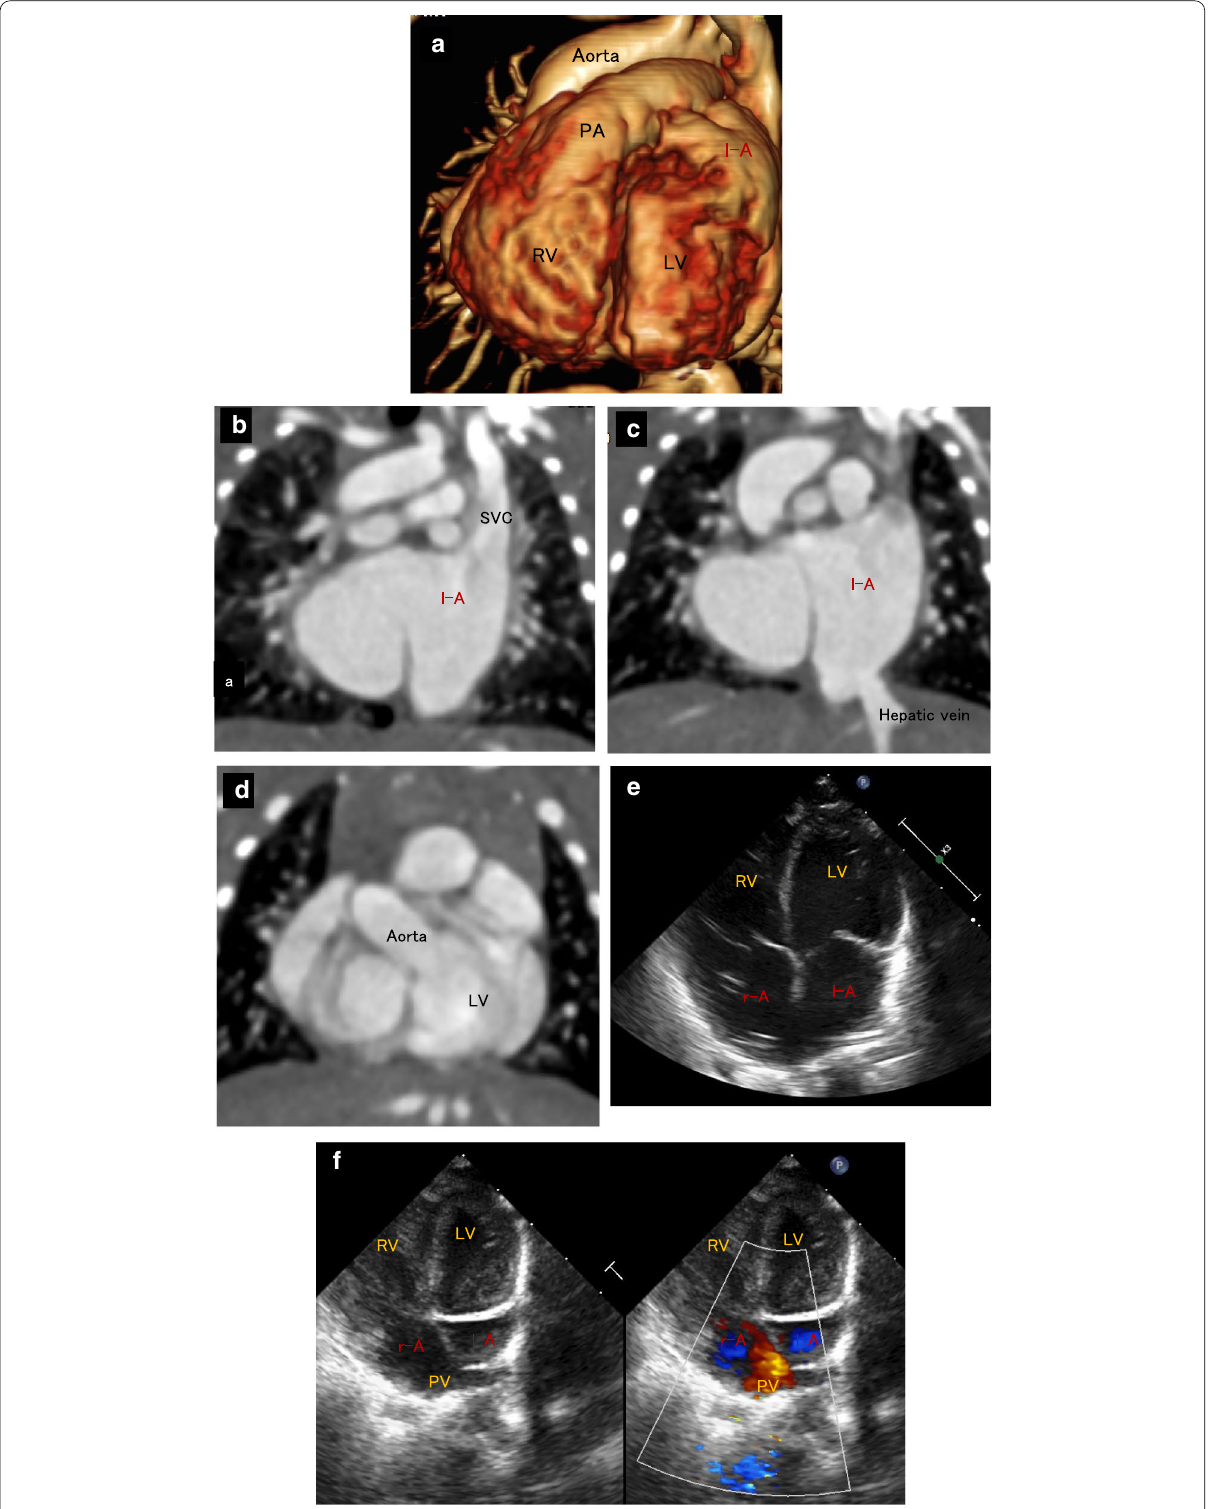
Fig. 1 The computed tomography scans ( a – d ), and the transthoracic echocardiography ( e , f ) obtained from the patient. These figures indicate situs ambiguous(inversus), D-loop, and D-Spiral, atrioventricular discordance, ventriculoarterial